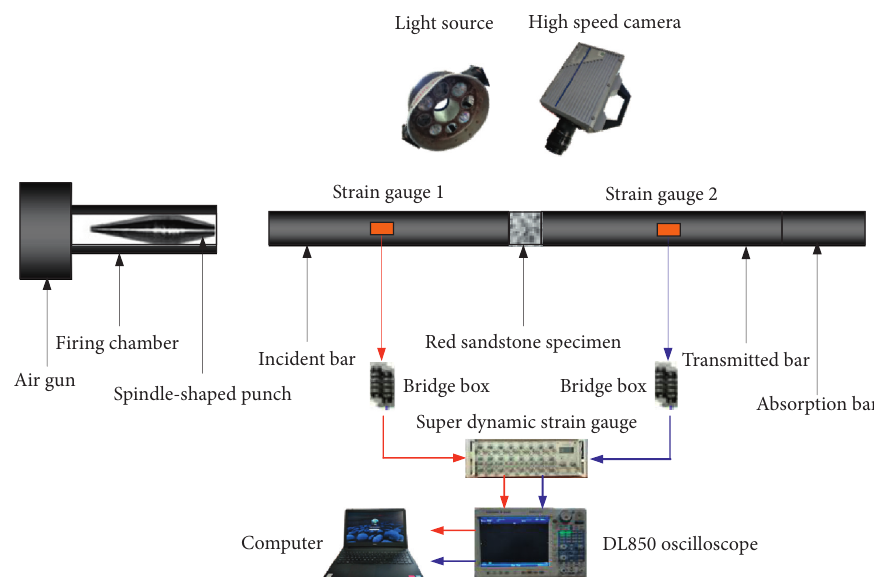
Figure 1: Diagram of the conventional SHPB testing system (Gong et al. [35, 37]).